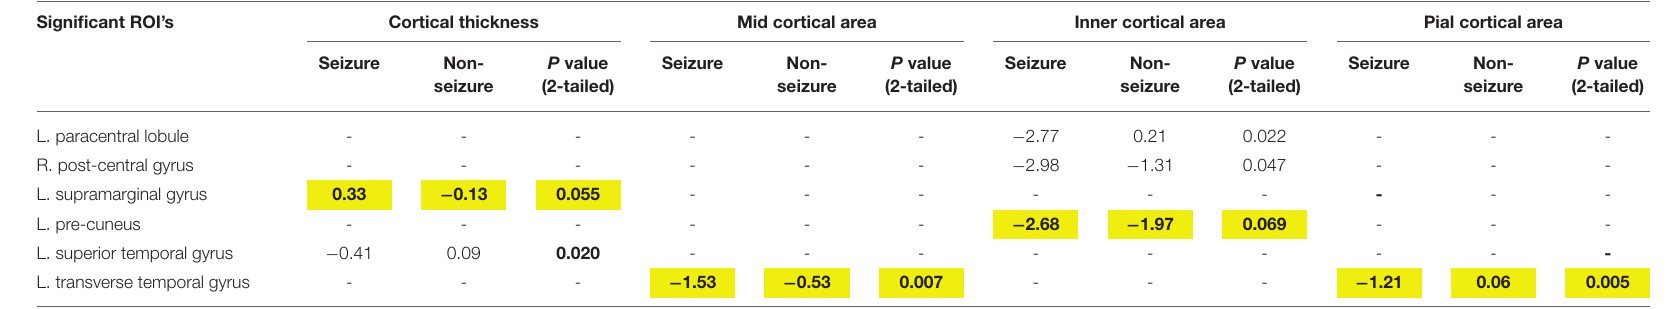
TABLE 3 | Mean differences in z-scores across Cortical Thickness and Cortical Area zones (mid, inner, and pial) across tumor patients with and without seizures using two-tailed significance. Significant ROI’s